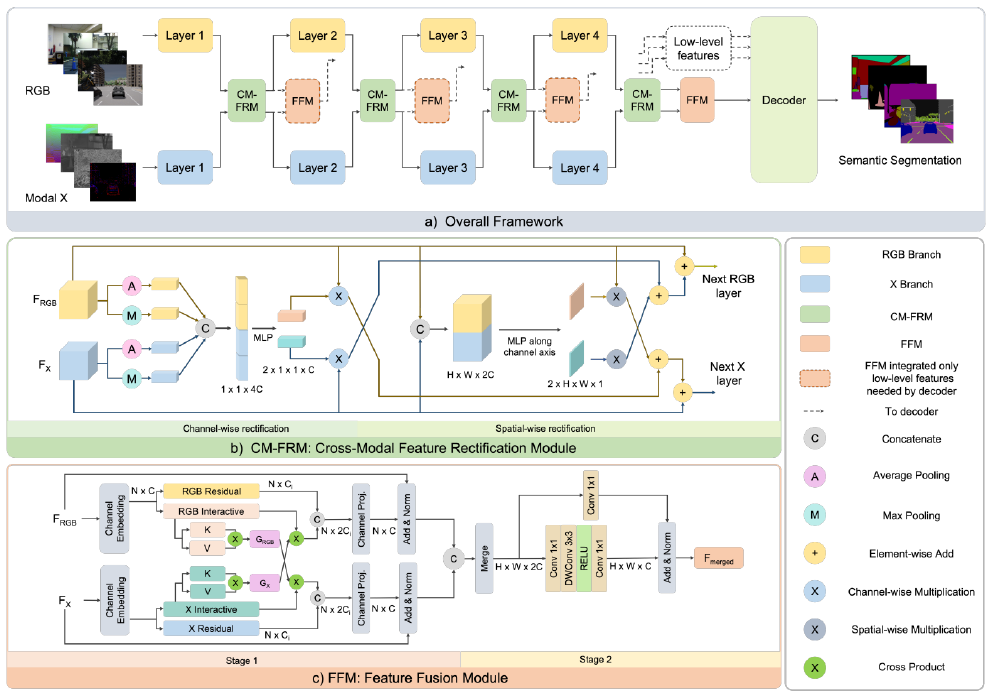
Figure 12. Figure from [99] where the CMX architecture and its modules are shown. Reprinted with permission from the authors of [99]. Copyright 2022, H.